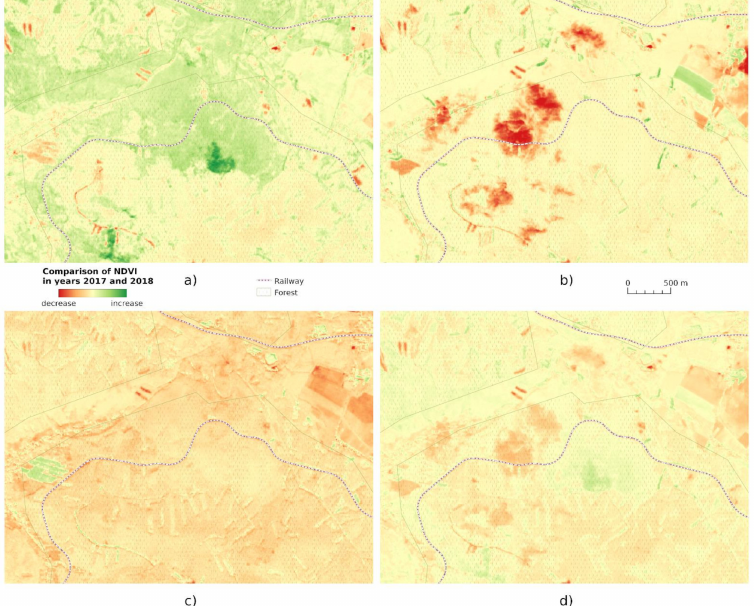
Figure 10. NDVI index changes in three periods and final average change: ( a ) difference between 11 May 2017 and 6 May 2018; ( b ) difference between 20 June 2017 and 3 July 2018; ( c ) difference between 29 August 2017 and 18 September 2018 and ( d ) average value of difference calculated from three periods depicted in ( a – c